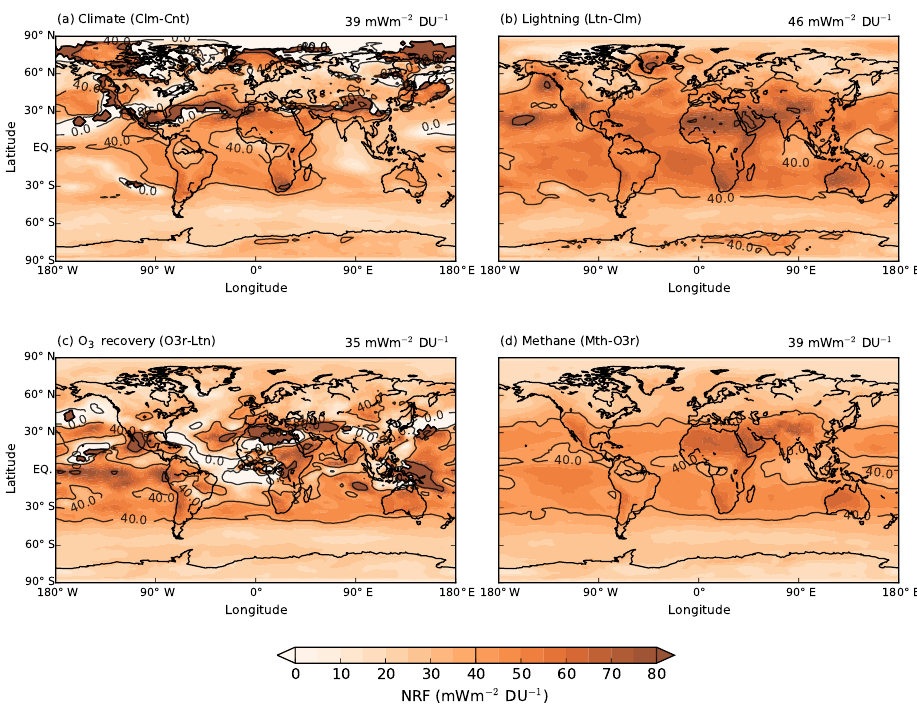
Figure 5. Annual mean maps of normalized tropospheric ozone radiative forcing (i.e. divided by the tropospheric column ozone change) due to (a) climate, (b) lightning, (c) O 3 recovery, and (d) methane. The annual global mean is shown on the top right corner (mWm − 2 DU − 1 )